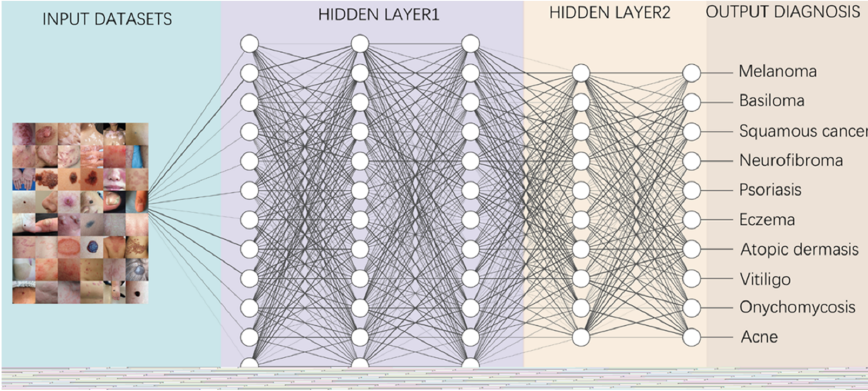
Figure 4. A diagram depicting how to perform classification tasks in an AI neural